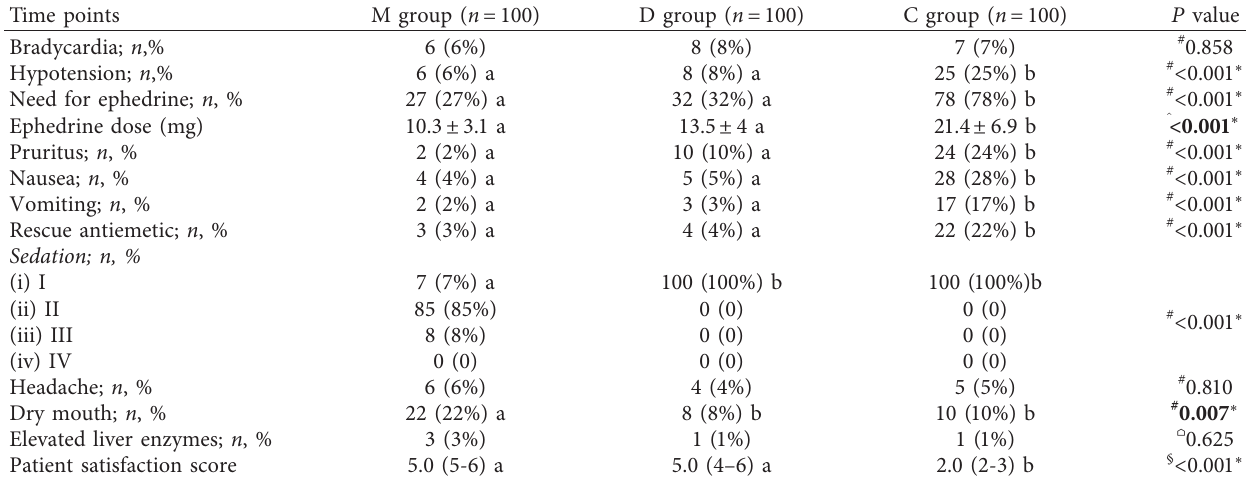
Table 3: Side effects, administered treatments, and patient satisfaction